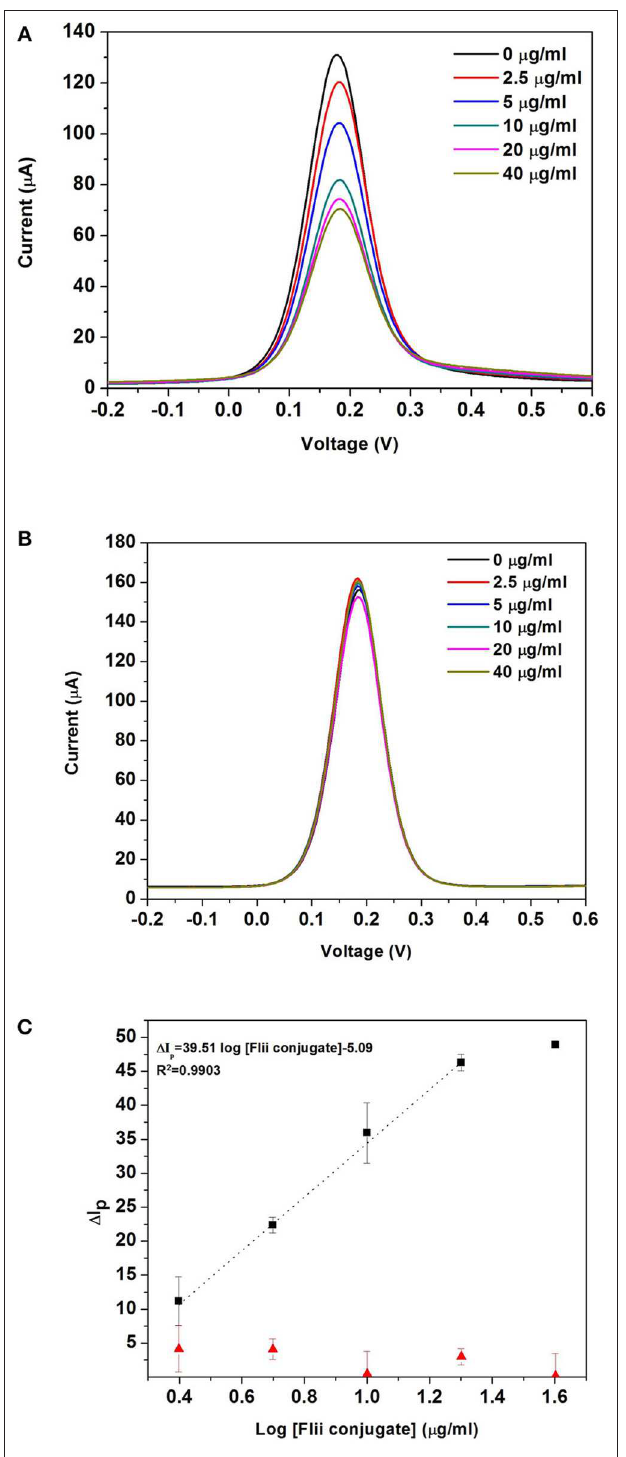
FIGURE 4 | DPV curves obtained with the NAA-based electrochemical immunosensor (A) , and the control sensor (B) in the absence of magnetic field; dose response curves for the detection of KLH-Flii peptide conjugate plotted using the NAA-based electrochemical immunosensor and control sensor in the absence of magnetic field (C) . Error bars are calculated as standard deviation from the average of three individual experiments.